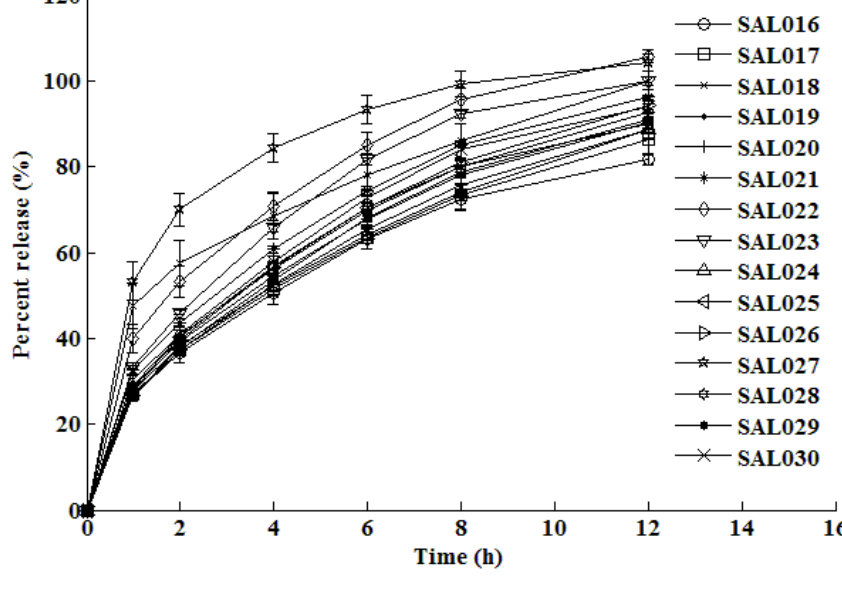
Figure 3. In vitro mean dissolution profiles of formulations SAL016 – SAL030 established from experimental